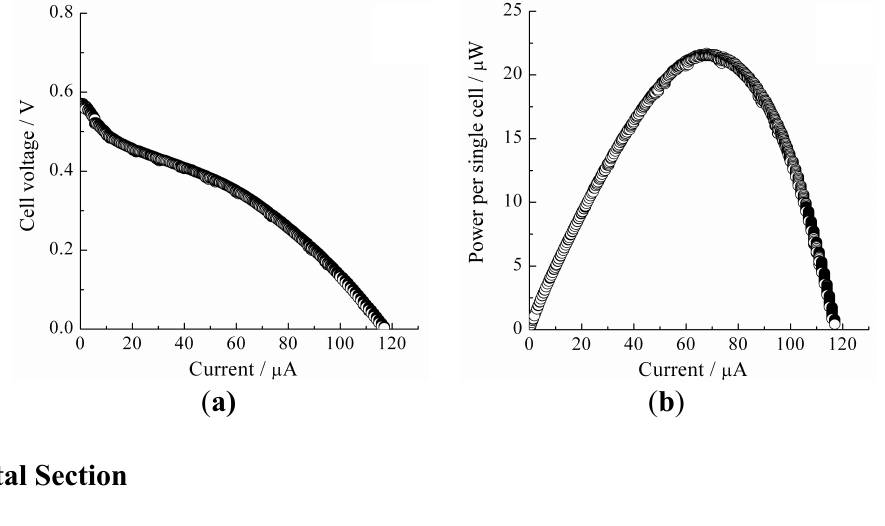
Figure 5. Cell performances of single cell type III: ( a ) I - V and ( b ) power characteristics per single cell type